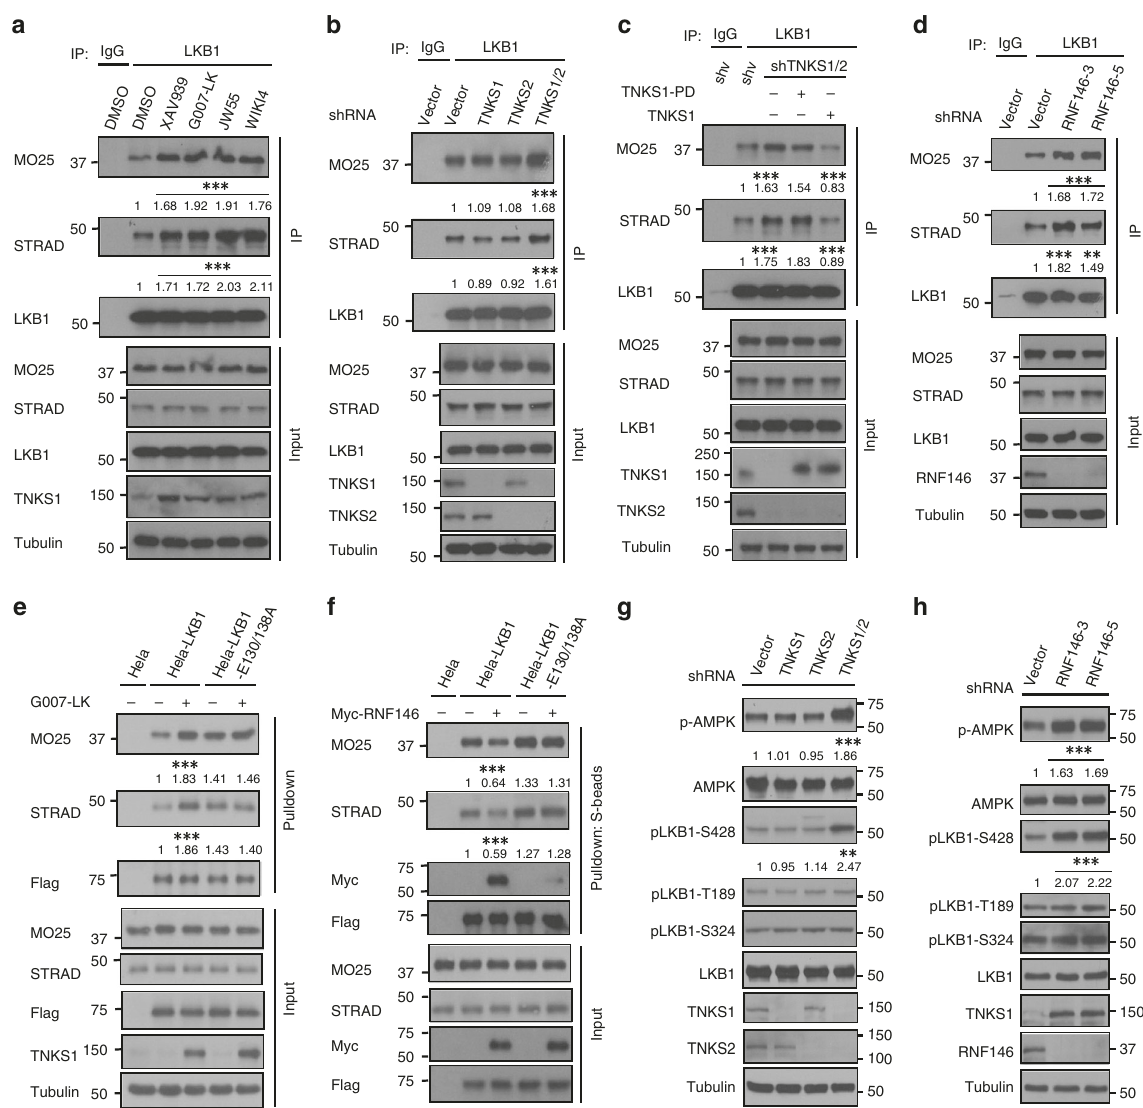
Fig. 4 Tankyrase-RNF146 axis is involved in regulation of LKB1 complex integrity and LKB1 phosphorylation. a Tankyrase inhibitor treatment enhances LKB1/STRAD/MO25 complex formation. HEK293A cells were treated with DMSO or the tankyrase inhibitors JW55. WIKI4, XAV939, or G007-LK, and subjected to immunoprecipitation/western blotting. We use the ImageJ to calculate the band densitometry of western blots, and get the relative ratio by comparing the densitometry of MO25/LKB1 or STRAD/LKB1, and we get three relative ratios from three independent experiments. The relative ratio data was analyzed by the One-way ANOVA test and we used an F-test to compare variances, a P value of <0.05 was considered to indicate statistically signi fi cant differences, ** means P -value of <0.01 and *** means P -value of <0.001 (shown in Supplementary Data 4). b TNKS1/2 depletion increases LKB1 complex formation. HEK293A cells were transduced with the indicated shRNAs and cell lysates were subjected to immunoprecipitation/western blotting. c Expression of TNKS1 but not the TNKS1-PD mutant disrupts LKB1 complex formation. shRNA-resistant inducible TNKS1 or TNKS1-PD were transducted into TNKS1/2-knockdown HEK293A cells, and cell lysates were subjected to immunoprecipitation. d Loss of RNF146 promotes LKB1 complex formation. HEK293A cells were transduced with the indicated shRNAs and cell lysates were subjected to immunoprecipitation/western blotting. e G007-LK treatment promotes complex formation of WT but not E130/138A mutant of LKB1 with STRAD/MO25. Indicated cells were treated without or with G007- LK and cell lysates were subjected to pull-down assay. f Overexpression of RNF146 inhibits complex formation of WT but not E130/138 A mutant of LKB1 with STRAD/MO25. HeLa cells stable expressed wild-type or the E130/138 A mutant of LKB1 was transfected without or with Myc-RNF146. Cell lysates were subjected to pull-down assay. g TNKS1/2 depletion induces LKB1 phosphorylation at Ser428. HEK293A cells were transduced with the indicated shRNAs, and phosphorylation of LKB1 at different sites was assessed with the corresponding antibodies. h Knockdown of RNF146 promotes LKB1 phosphorylation. HEK293A cells were transduced with the indicated shRNAs and subjected to western blotting. Statistical signi fi cance was determined by a two-tailed, unpaired Student ’ s t- test. * P < 0.05; ** P < 0.01; *** P <